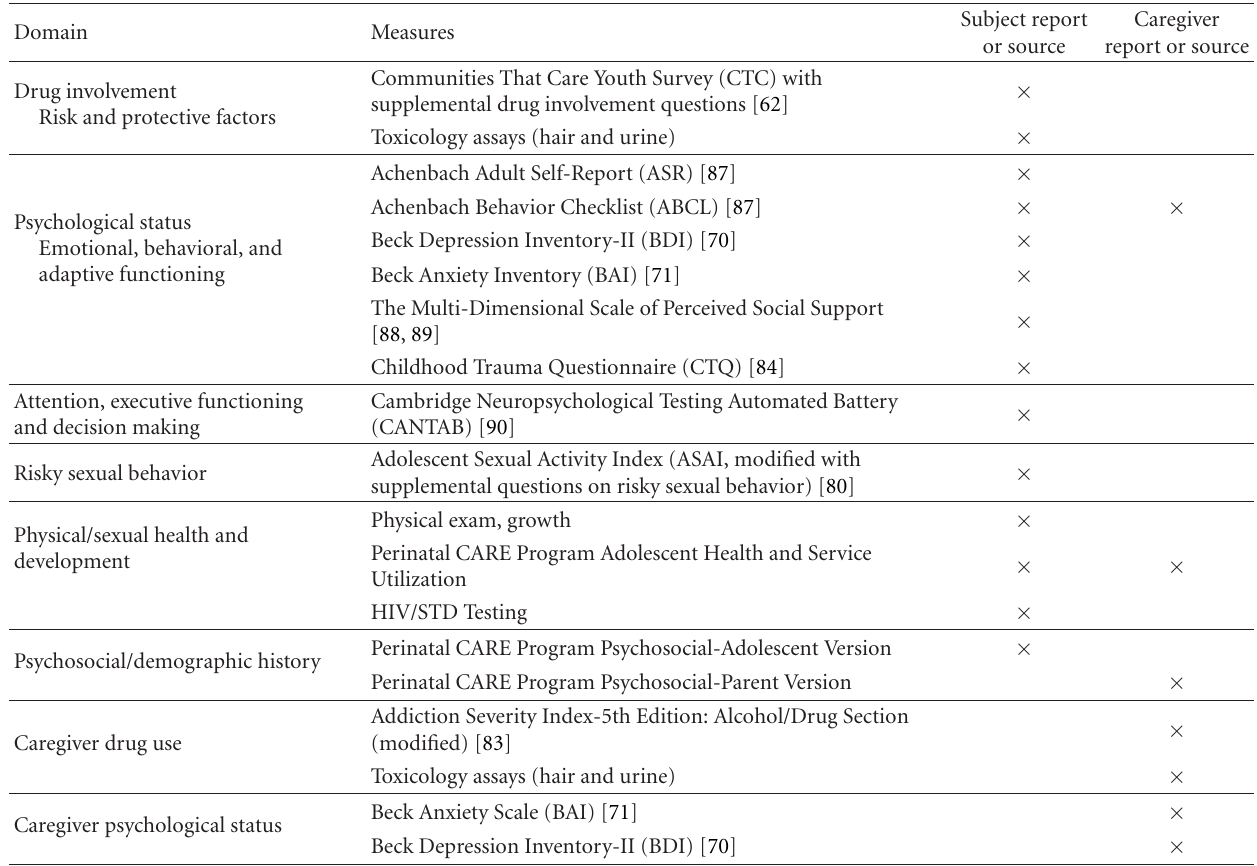
Table 5: Behavioral health assessments of the adolescents and caregivers at the 18/19-year